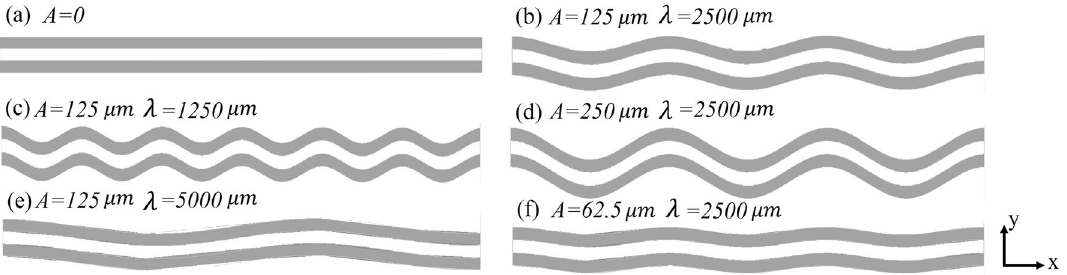
Figure 2. The top view of a part of ( a ) Straight microchannel, ( b ) Wavy case 1, ( c ) Wavy case 2, ( d ) Wavy case 3, ( e ) Wavy case 4 and ( f ) Wavy case